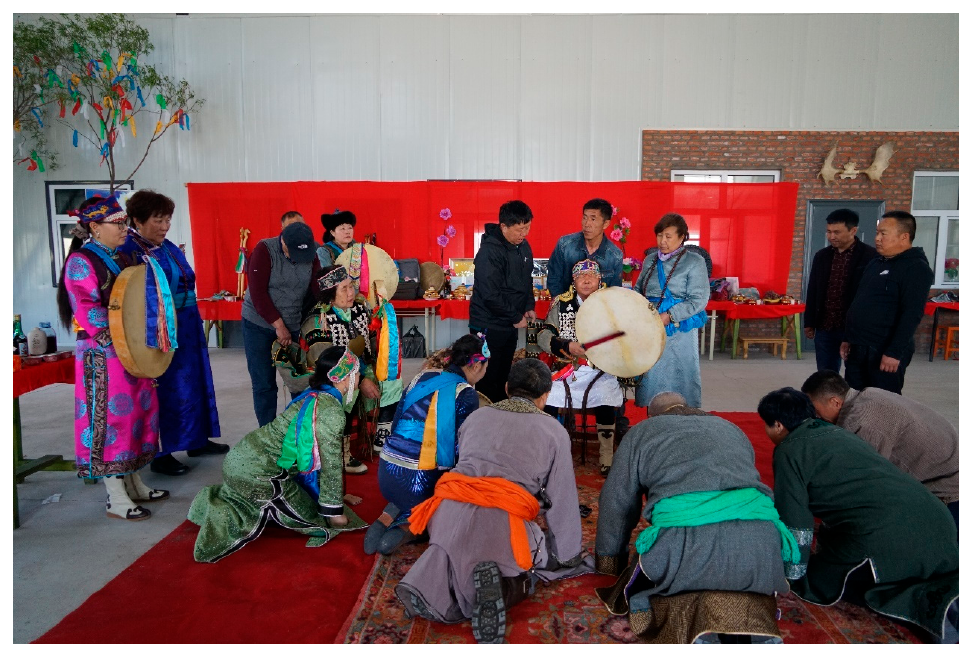
Figure A6. Shaman Wo Jufen’s ʊ ŋ ɡ ʊ r was coming (On 2 June 2017, the ritual to offer sacrifices to the ancestral spirit of Enen Duola) Photo: Minna Sa, 2017.